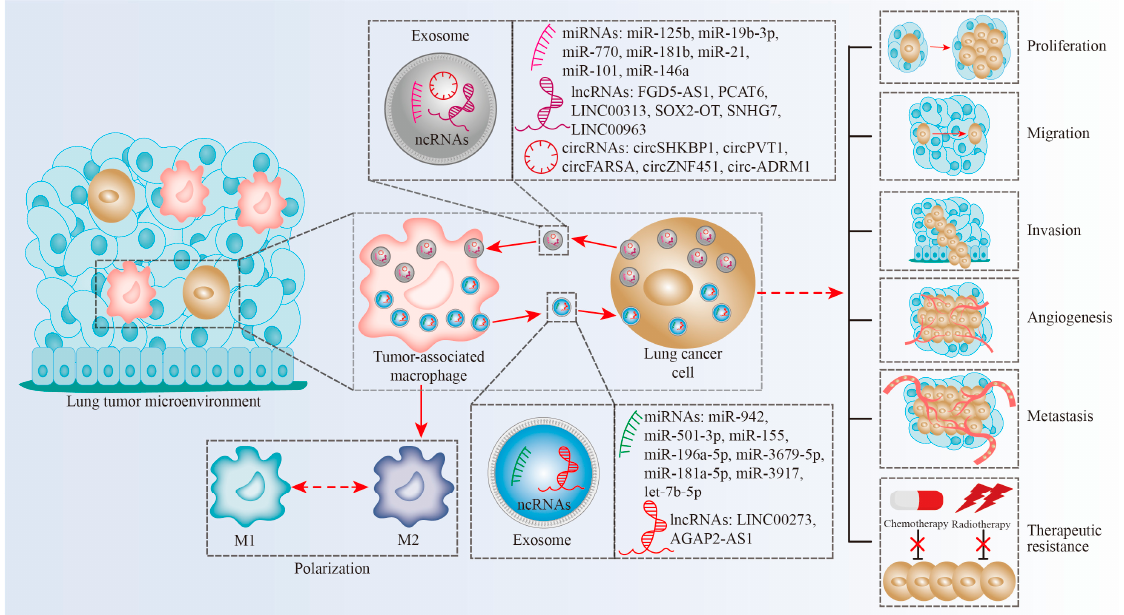
Figure 1. Exosomal ncRNAs modulate interplay between TAMs and lung cancer cells in lung TME. Tumor cells secrete exosomal ncRNAs to induce TAM polarization. TAMs deliver exosomal ncRNAs into lung cancer cells and influence cancer proliferation, migration, invasion, angiogenesis, metastasis, and therapeutic resistance. Table 1. Summary of e ff ects of exosomal ncRNAs on lung cancer.